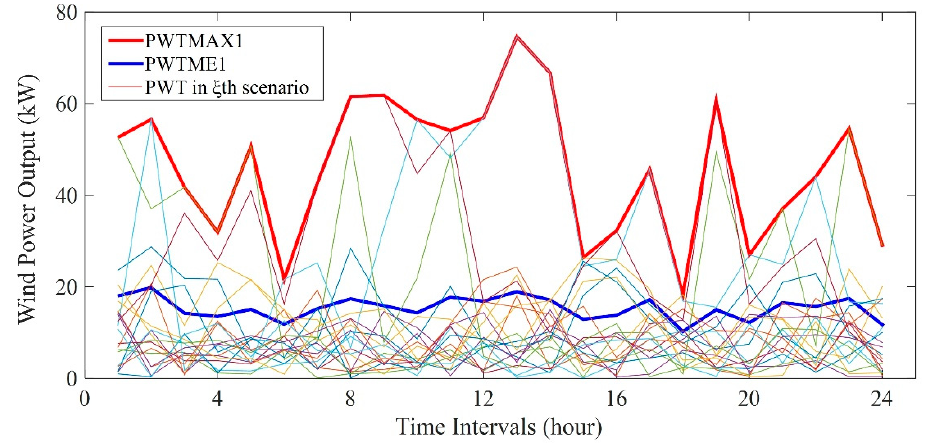
Figure A3. ( a ) Schematic diagram of EM clearing prices at day-ahead stage on the typical winter day; ( b ) Schematic diagram of EM clearing prices at real-time stage on the typical winter day.